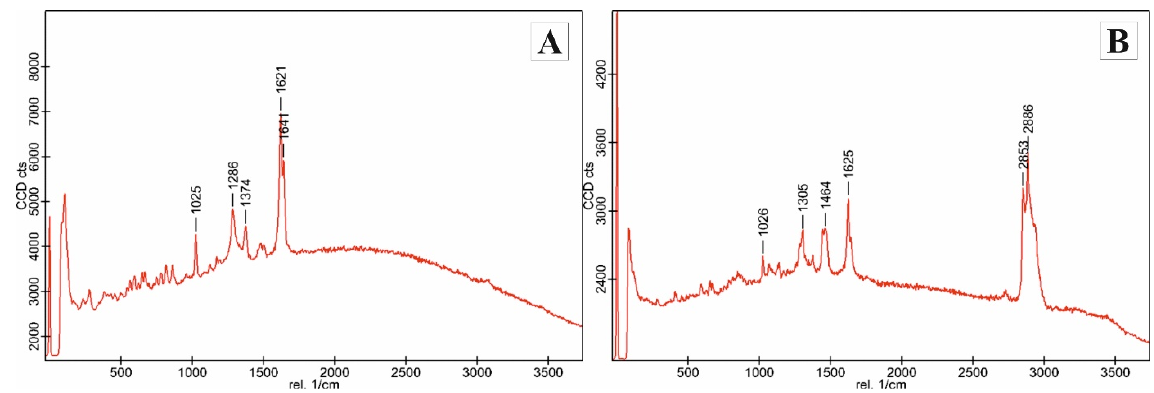
Figure 2. Raman spectra of taxifolin ( A ) and cream with 3% taxifolin ( B ). The representative Raman maps plotting the distribution of the cream with 3% TXF in the cross-section of the skin for a photomicrograph, taken in visible light, are presented in Figure 3.